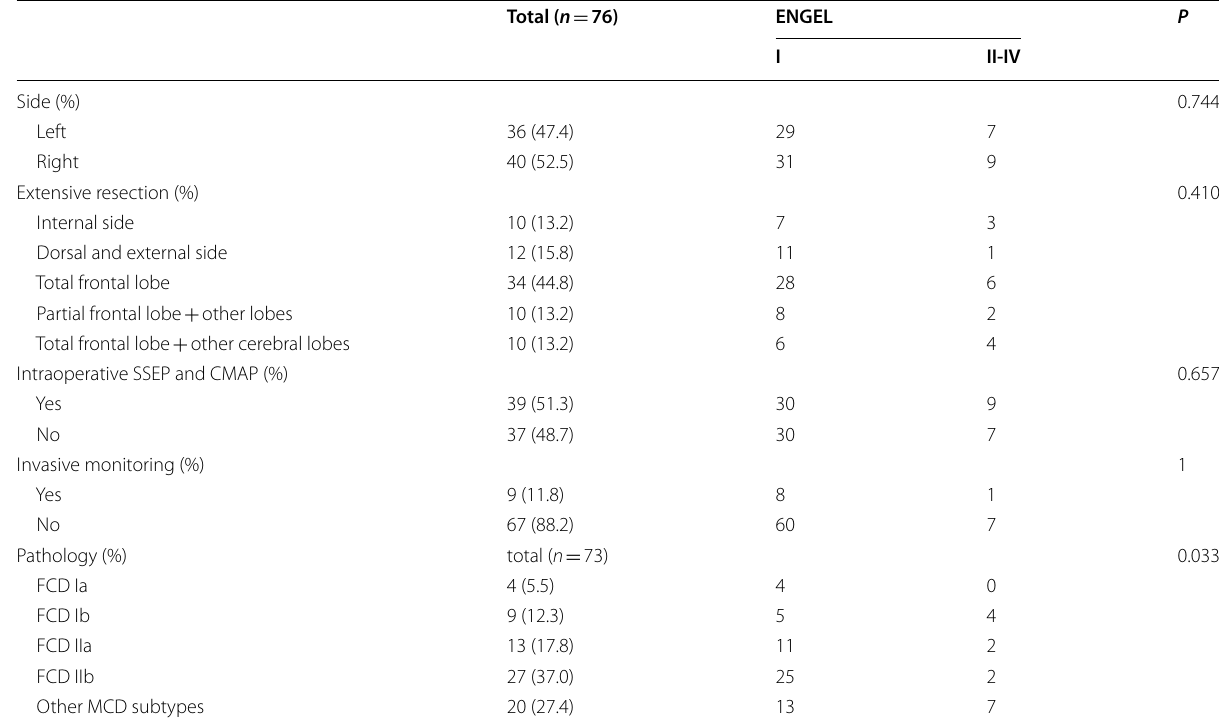
Table 2 Surgical data and pathology